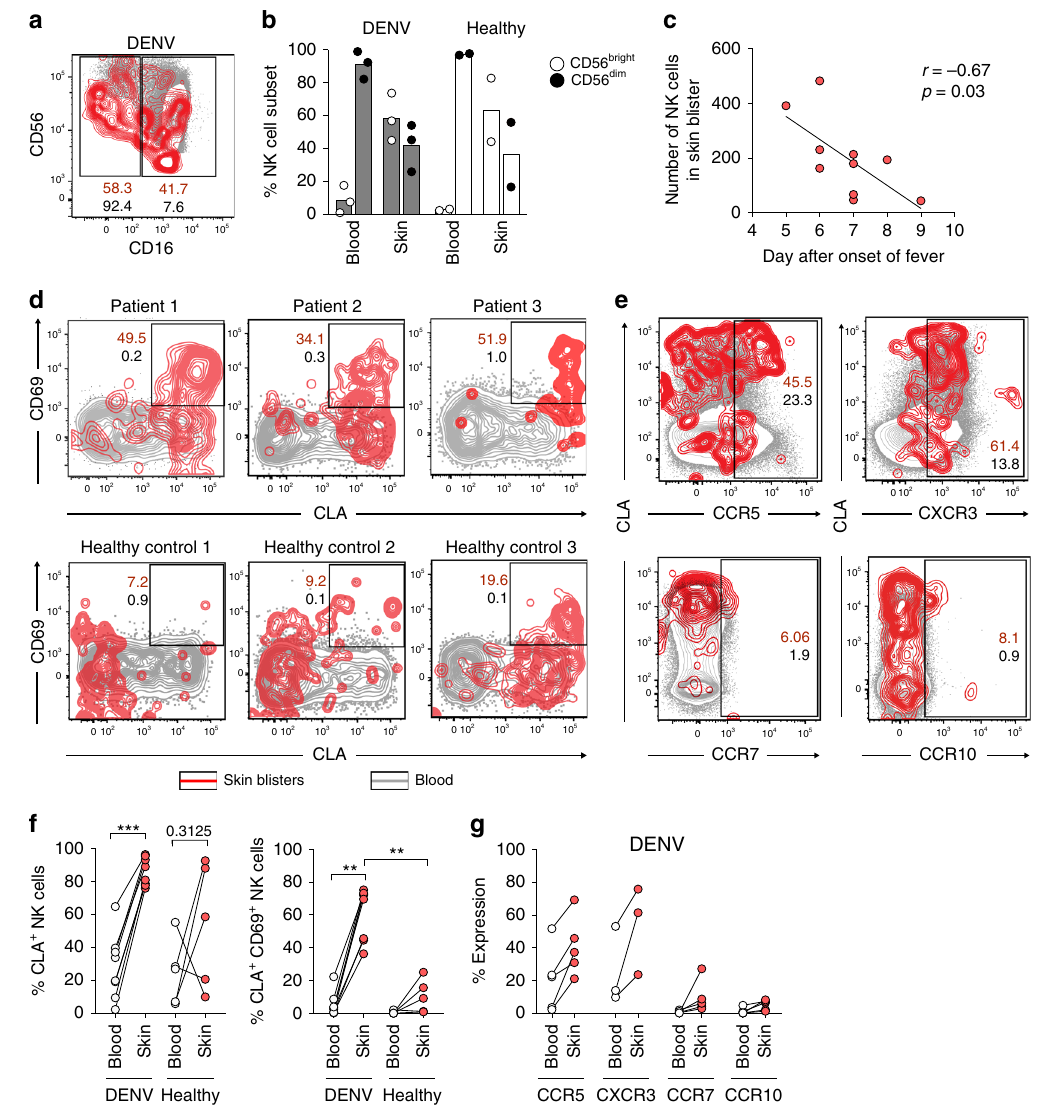
Fig. 8 CLA + CXCR3 + CCR5 + CD69 + natural killer (NK) cells are present in the skin during acute dengue virus (DENV) infection. a Representative plot showing CD56 bright NK cells and CD56 dim NK cells from isolated from skin blisters (red overlay) and matched peripheral blood (gray background) that is summarized in b (DENV patients n = 3, healthy controls n = 2). c Spearman ’ s correlation between number of NK cells isolated from skin blisters and the day of sample collection (day after symptom debut). d Representative staining for CD69 and CLA (upper panels) on NK cells from skin blister fl uid (red overlay) and peripheral blood mononuclear cell (PBMC) (gray background) of three patients with acute DENV infection, and three healthy controls (lower panel). e Representative staining for CCR5, CXCR3 (upper panel), CCR7, and CCR10 (lower panel). f Summary data of d for CLA and CD69 expression on NK cells from DENV patients ( n = 8) and healthy controls ( n = 5). g Summary data of e for chemokine receptor expression on NK cells from DENV- infected patients ( n = 3 – 5). Statistical differences were tested in using paired t test, Wilcoxon ’ s matched-pairs signed-rank test and Mann – Whitney